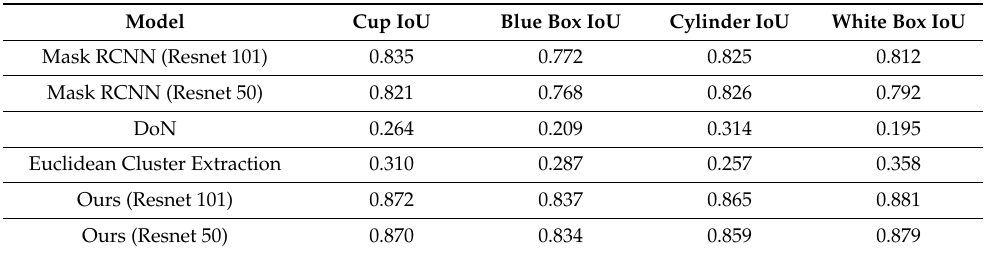
Table 1. IoU of our approach in comparison to original Mask R-CNN and 3D traditional segmenta- tion algorithms.